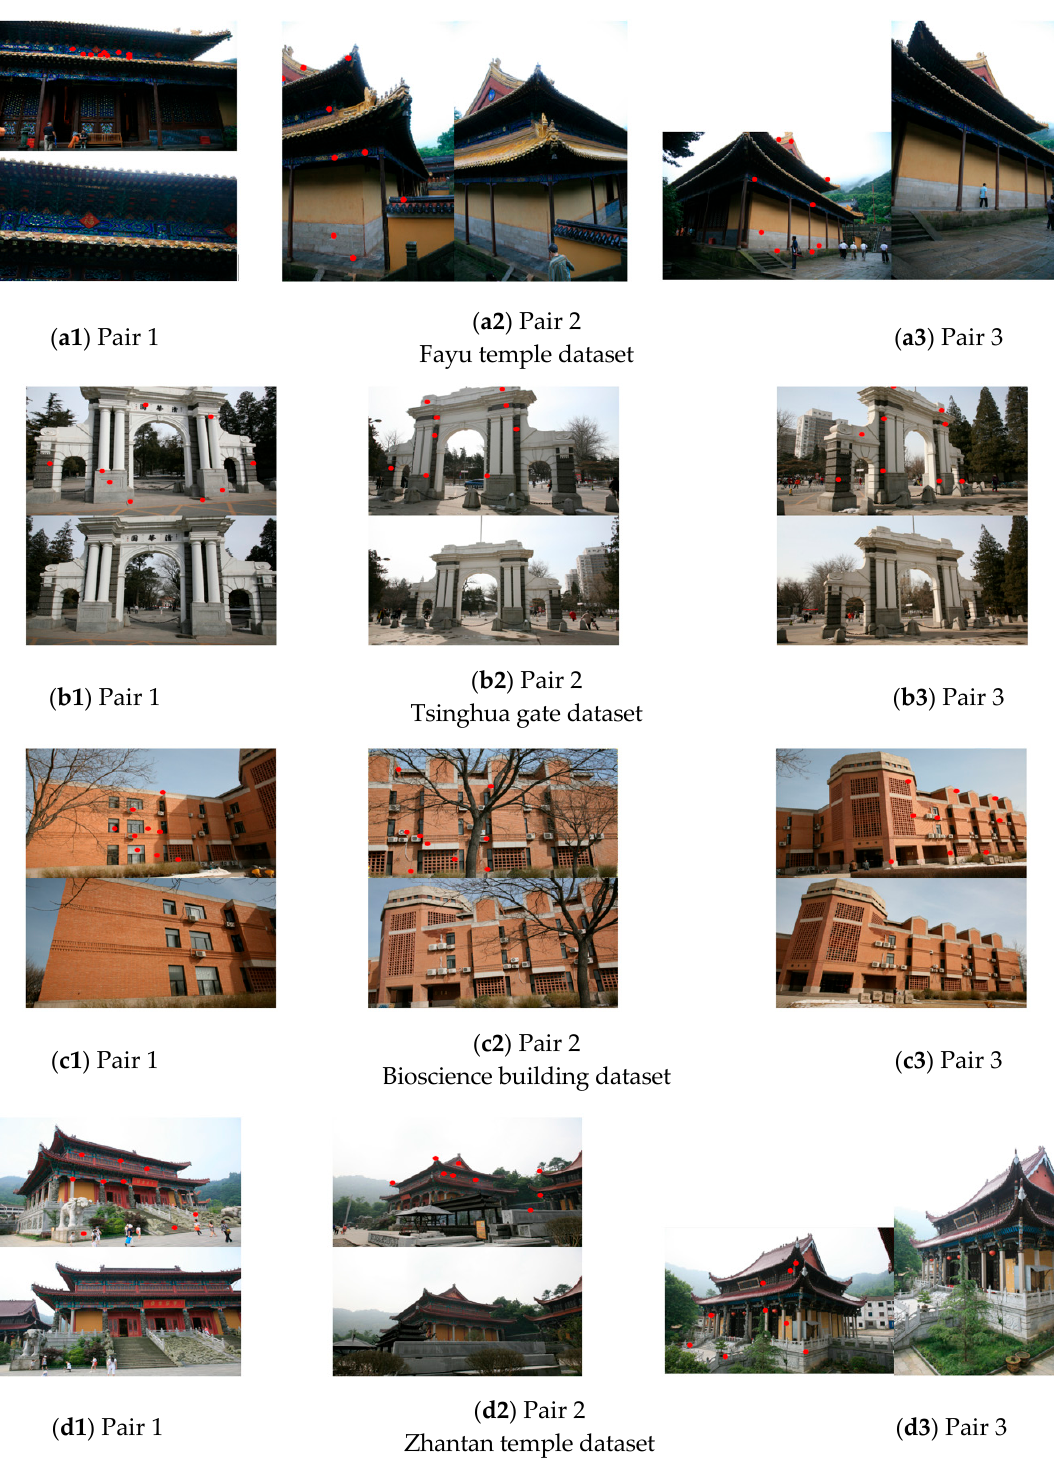
Figure 3. The close-range datasets for experimental analysis and comparisons.